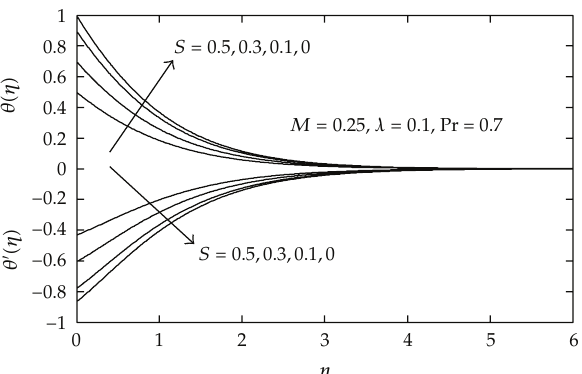
Figure 3: Variation of temperature θ (cid:6) η (cid:7) and temperature gradient θ (cid:4) (cid:6) η (cid:7) with η for several values of the stratification parameter S when M (cid:9) 0.25, λ (cid:9) 0 . 1, and Pr (cid:9) 0.7.